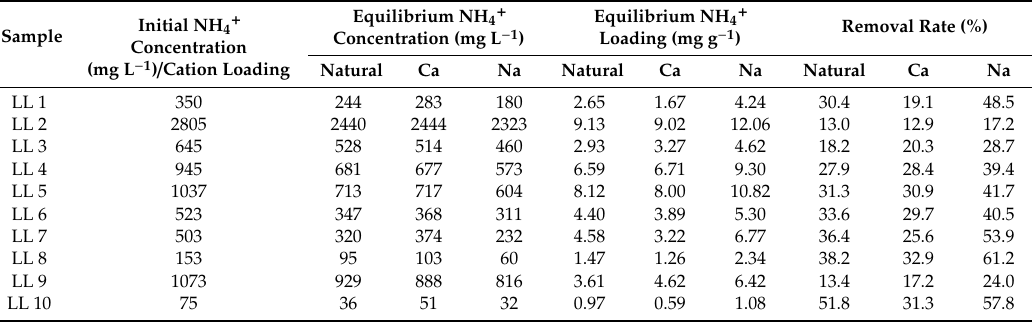
Table 2. Landfill leachates (LL) used for NH 4 + ion exchange experiments, their initial concentration, equilibrium concentration, equilibrium loading and the corresponding removal rates using di ff erently pre-treated